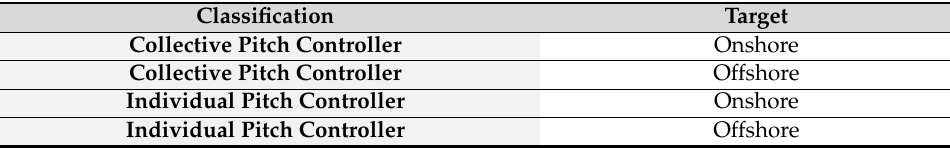
Table 1. Classification to pitch controller of floating wind power generation system.